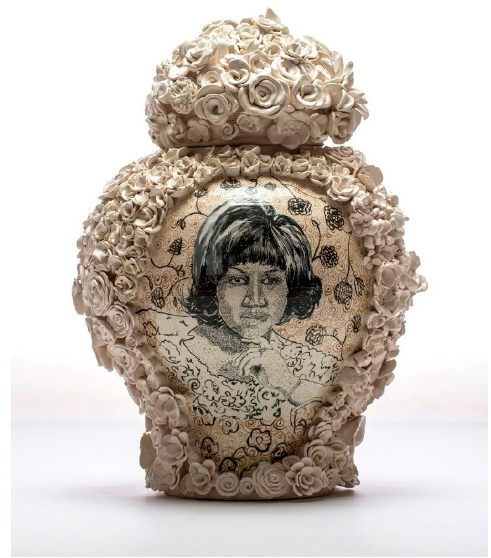
Figure 15. When They Go Low We Go High , 2018 , Porcelain, China Paint, Luster, 25 × 16 × 14 in. Image by KeneK Photography, courtesy of Wexler Gallery.